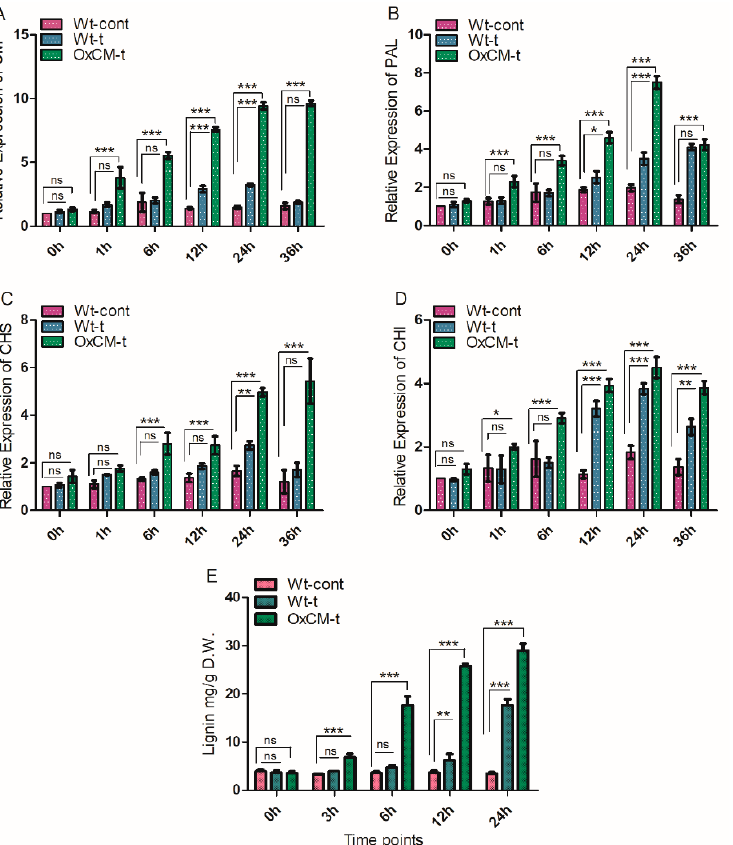
Figure 3. Over-expression of chorismate mutase ( CM ) gene positively regulates downstream genes and lignin accumulation. Relative transcriptional accumulation of ( A ) CM gene, ( B ) PAL gene, ( C ) CHS gene, and ( D ) CHI gene in the wild-type control (Wt-cont); wild-type infected with WBPH (Wt-t) and chorismate mutase transgenic over-expressor infected with WBPH (OxCM-t) plants in response to WBPH infestation. The relative expression of each gene was measured after 0, 1, 6, 12, 24, and 36 h of WBPH infestation. The actin gene was used as a reference gene. ( E ) Lignin quantification after 0, 3, 6, 12, and 24 h of infestation. Graph bars indicate the mean ± standard deviation ( n = 3), ns indicates non significant and asterisks indicate significant differences (* p < 0.05, ** p < 0.01, *** p < 0.001) analyzed using two-way analysis of variance and Bonferroni post hoc test. The experiments were repeated three times.